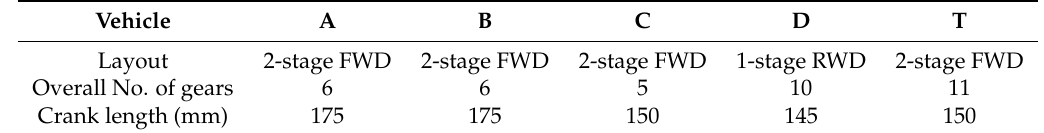
Table 2. Characteristics of compared